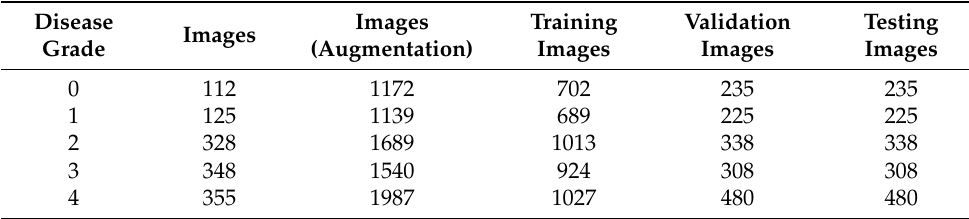
Table 2. Data sets before and after image enhancement processing.